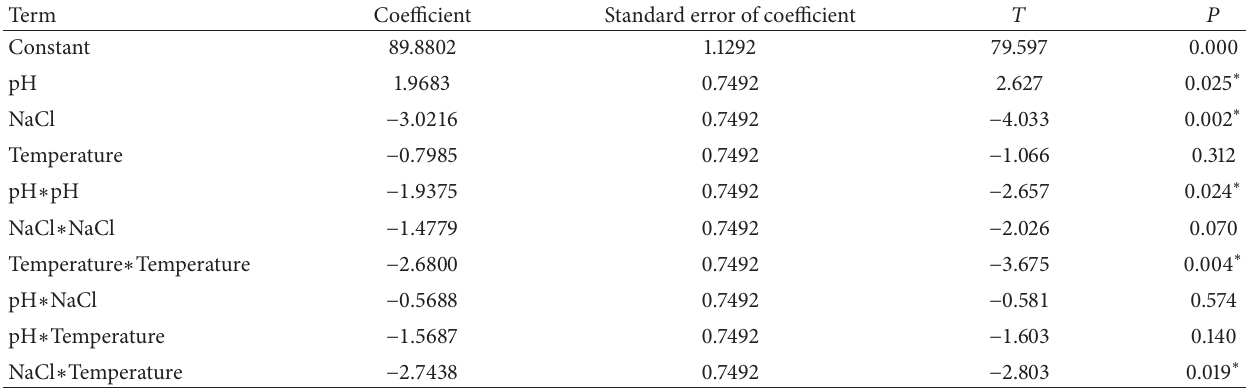
Table 4: Estimated regression coefficients for percentage recovery.